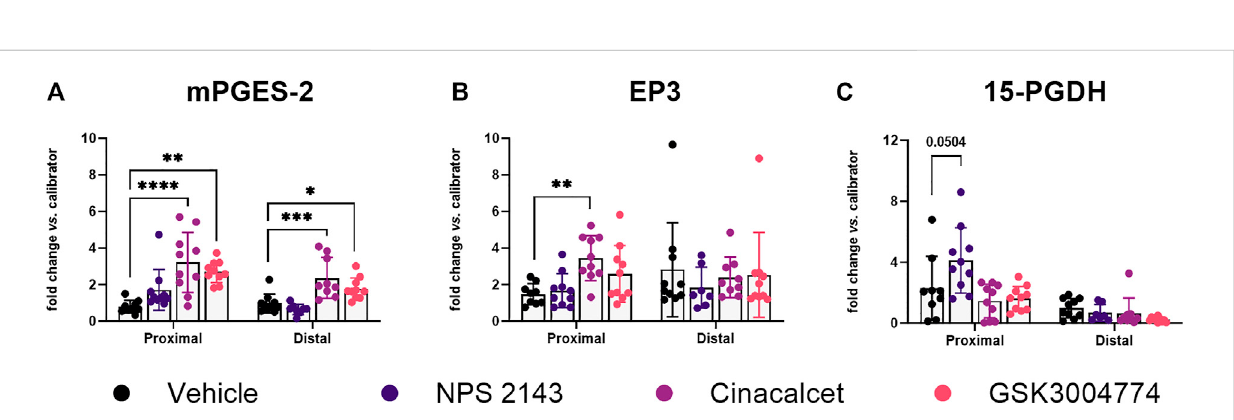
FIGURE 7 Altered PGE 2 pathway genes in CaSR-ligand treated mice with colitis. Relative gene expression of (A) mPGES-2, (B) EP3, and (C) 15-PGDH in the colons of mice with DSS-induced colitis treated with CaSR allosteric modulators (each 10 mg/kg). Mean ± SD, N = 7 – 10. Proximal and distal colon were analyzed separately by one-way ANOVA with Dunnett ’ s post hoc test vs. vehicle control (20% cyclodextrin), * p < 0.05, ** p < 0.01, *** p < 0.001, **** p < 0.0001.